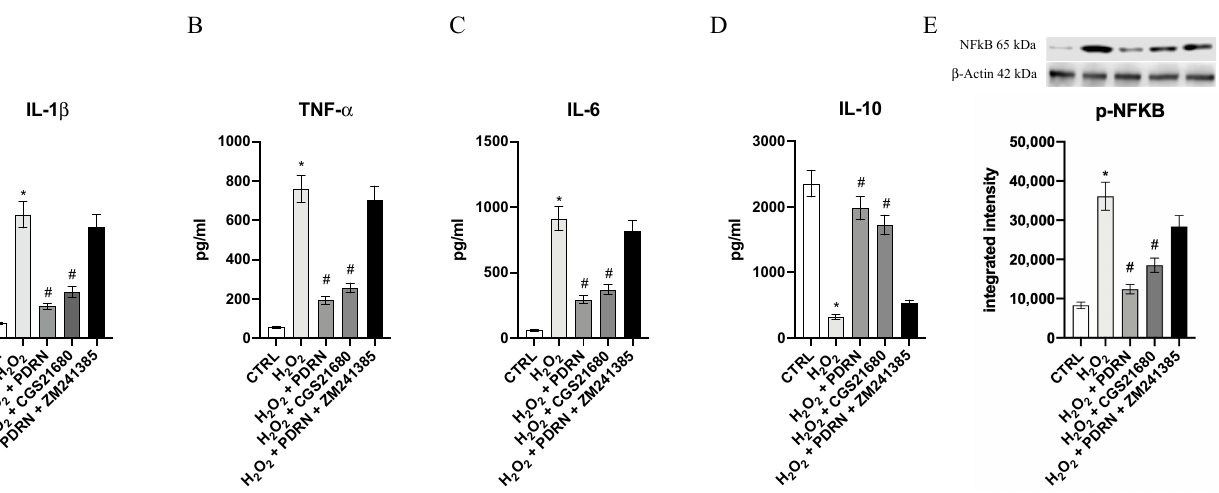
Figure 4. The graphs represent the Il-1 β ( A ), TNF- α ( B ), Il-6 ( C ), Il-10 ( D ) and p-NF- κ B ( E ) protein expression in IHCE cells. The values are expressed as the means and SD. * p < 0.0001 vs. CTRL; # p < 0.0001 vs. H 2 O 2 .